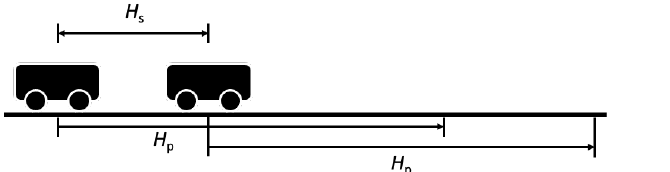
Figure 3. Receding Horizon approach with identification of the path length H p and updating inter- val H s